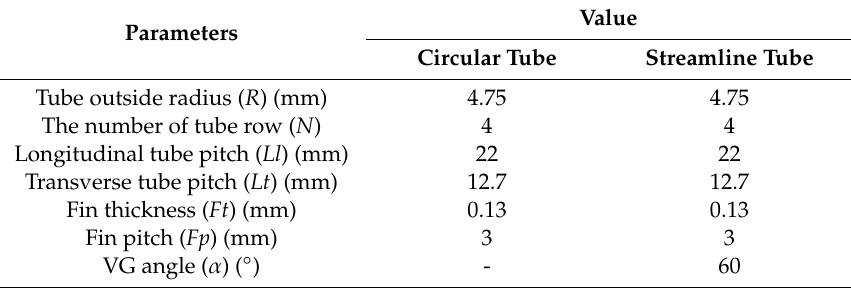
Table 1. The parameters of circular tube and streamline tube fin-tube heat exchanger.